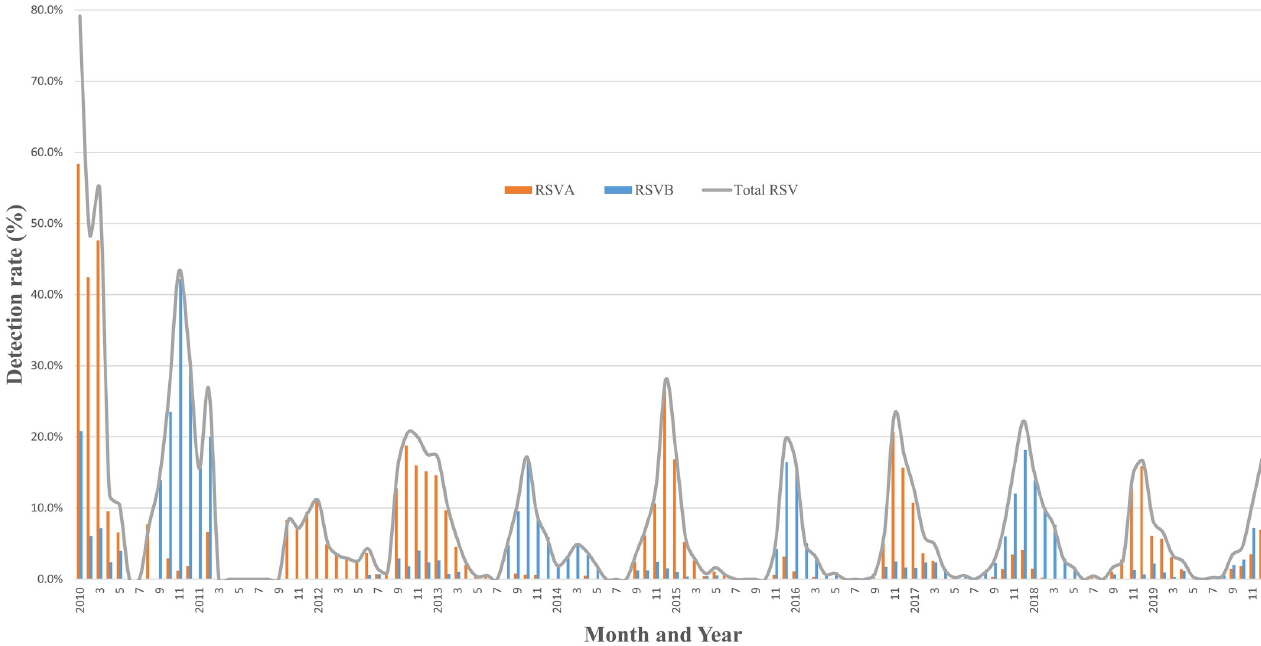
Fig 1. Seasonal outbreaks patterns and detection rate of RSV in Seoul from 2010 to 2019. Seasonal outbreaks patterns and detection rate of RSV in patients who visited Korea University Guro Hospital between January 2010 and December 2019. The detection rate of RSV-A and RSV-B was calculated as the percentage of positive cases detected among the total number of tests performed using either the multiplex RT-PCR (Seeplex 1 RV15 One-Step ACE Detection assay or Anyplex ™ II 16 detection kit) or culture method. The x-axis of the graph represents the months of the year from January to December, while the y-axis represents the detection rate of RSV as a percentage. The orange line represents the detection rate of RSV-A, and the blue line represents the detection rate of RSV-B.